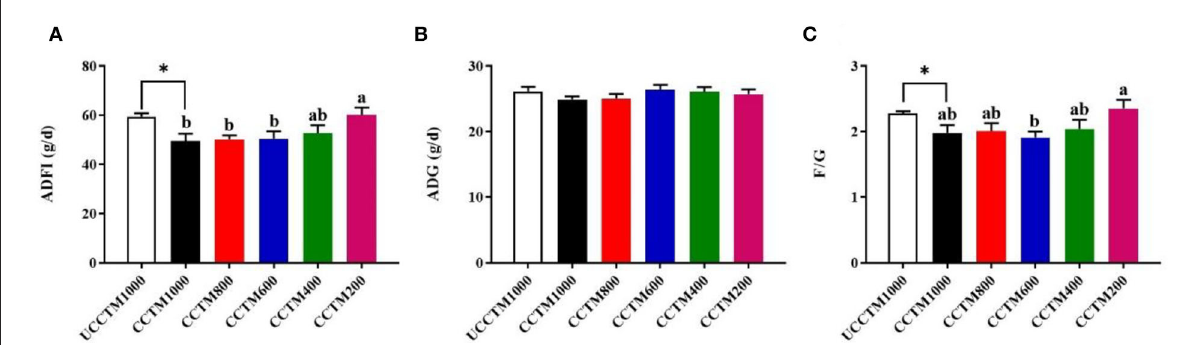
FIGURE1 Effects of dietary coated complex trace minerals (TMs) on the growth performance of yellow-feathered broilers. (A–C) The 1 to 56 days of age average daily feed intake (ADFI), average daily gain (ADG), and feed to gain ratio (F/G) of yellow-feathered broilers. Results are mean value ± standard error (SE); n = 6 for each group. * P < 0.05 for the UCCTM1000 group vs. The CCTM1000 group. Mean values with different small letters denote significant differences among CCTM groups ( P < 0.05). UCCTM1000, supplemented with 1,000 mg/kg uncoated complex trace minerals; CCTE1000, supplemented with 1,000 mg/kg of coated complex trace minerals; CCTE800, supplemented with 800 mg/kg of coated complex trace minerals; CCTE600, supplemented with 600 mg/kg of coated complex trace minerals; CCTE400, supplemented with 400 mg/kg of coated complex trace minerals; CCTE200, supplemented with 200 mg/kg of coated complex trace minerals.